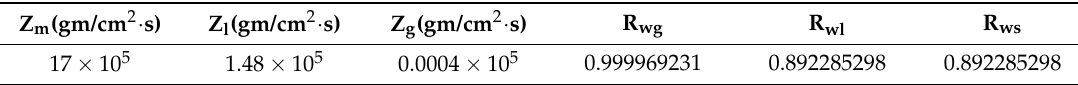
Table 1. Experimental parameters and initial values.